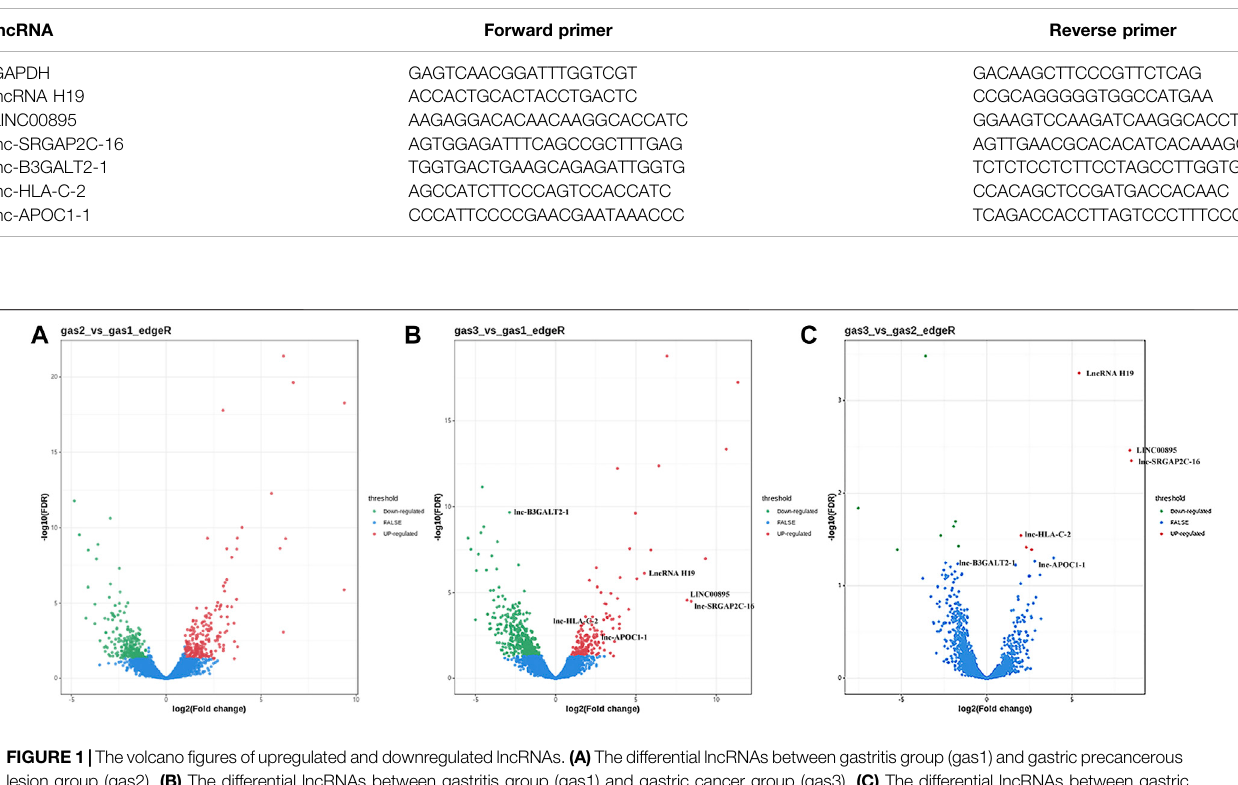
TABLE 1 | Primer sequences used for RT-qPCR.